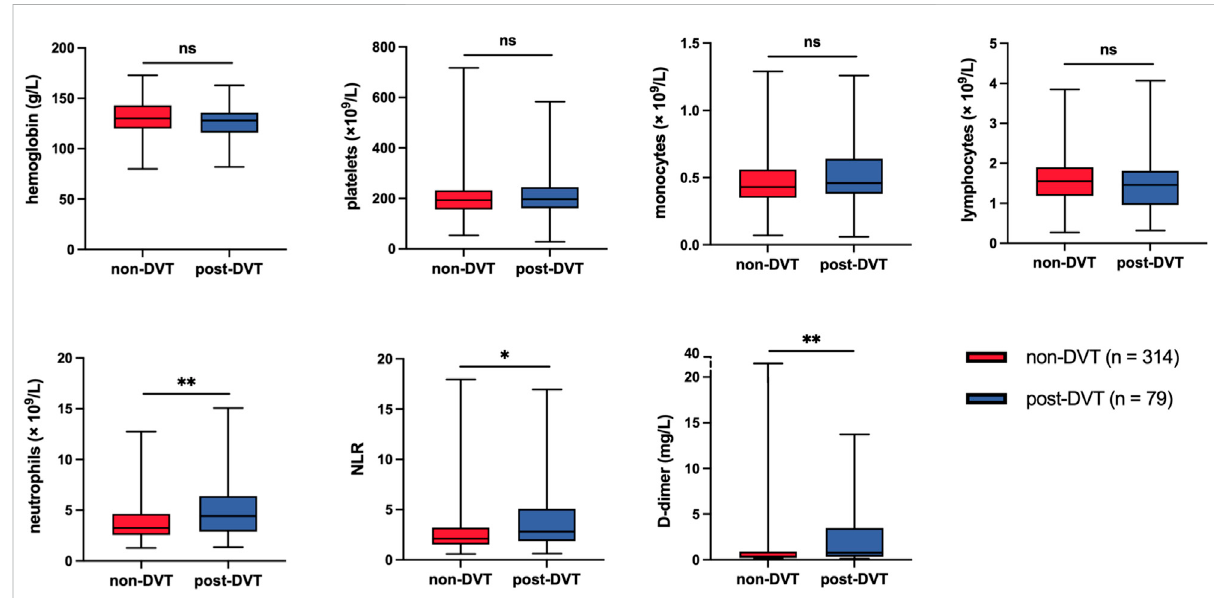
FIGURE 3 Statistical analysis of laboratory data after admission to hospital between the two study groups. ns, no signi fi cance; * p < 0.05; ** p < 0.01; NLR, neutrophil – lymphocyte ratio.